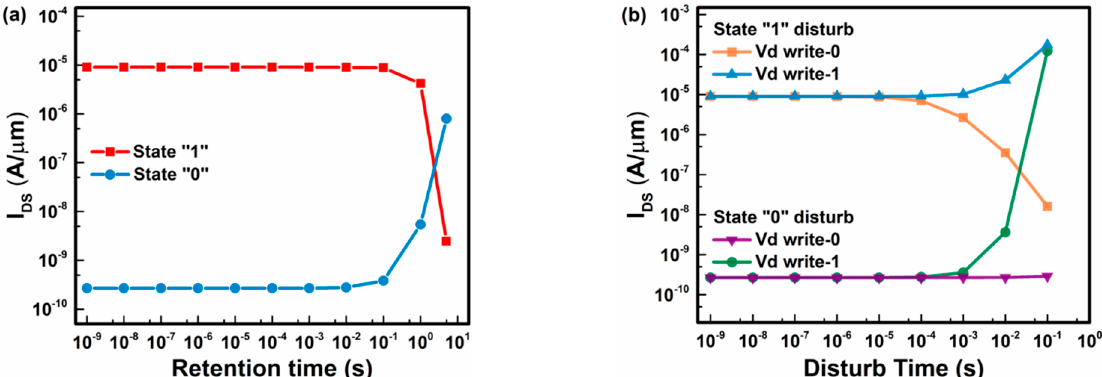
Figure 5. ( a ) Retention performance of the U-shaped SFGT memory. The retention time is over 1 s; ( b ) Disturbance performance of the U-shaped SFGT memory. The immunity time to the worst disturbance mechanism can be up to 10 ms.